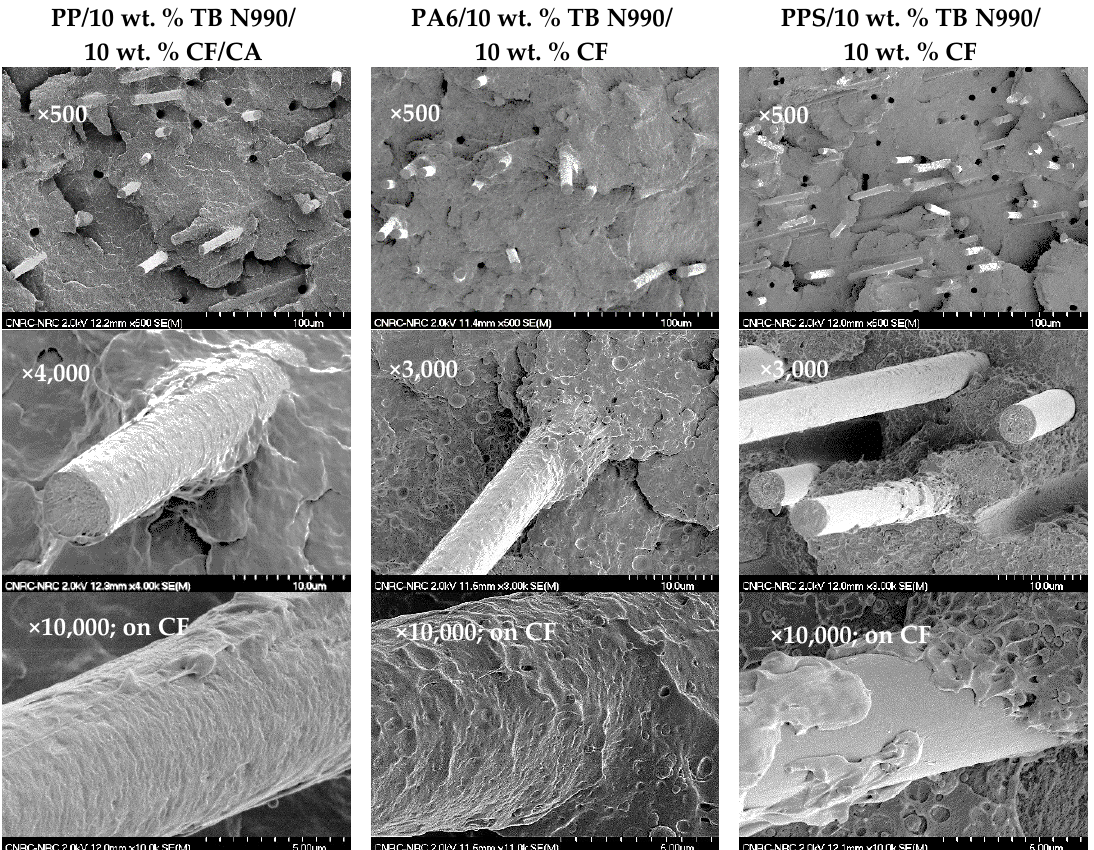
Figure 10. SEM micrographs of fractured surfaces for: the hybrid PP / 10 wt. % TB N990 / 10 wt. % CF / CA-1st column, the hybrid PA6 / 10 wt. % TB N990 / 10 wt. % CF-2nd column, and for hybrid PPS / 10 wt. % TB N990 / 10 wt. % CF-3rd column.